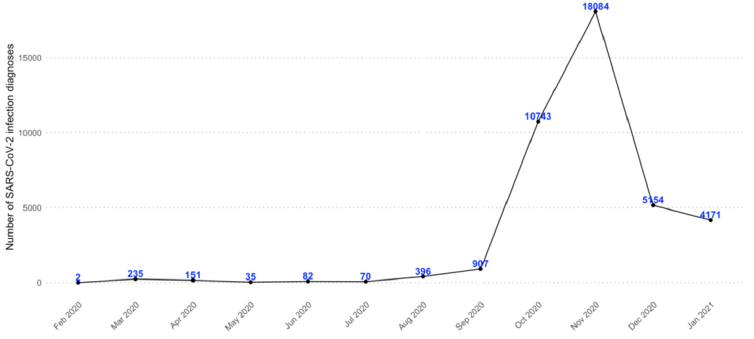
Figure 1. Monthly frequency of SARS-CoV-2 infection confirmed diagnoses in the period 21 February 2020–31 January 2021, in Caserta Local Health Unit. Overall, the male/female ratio of COVID-19 patients was equal to 1.0, even if deceased patients were mostly males (N = 417; 57.9%); the median age of COVID-19 patients was 44 (IQR: 27–58) years. More than half of these patients were asymptomatic at the time of diagnosis (Supplementary Table S4).